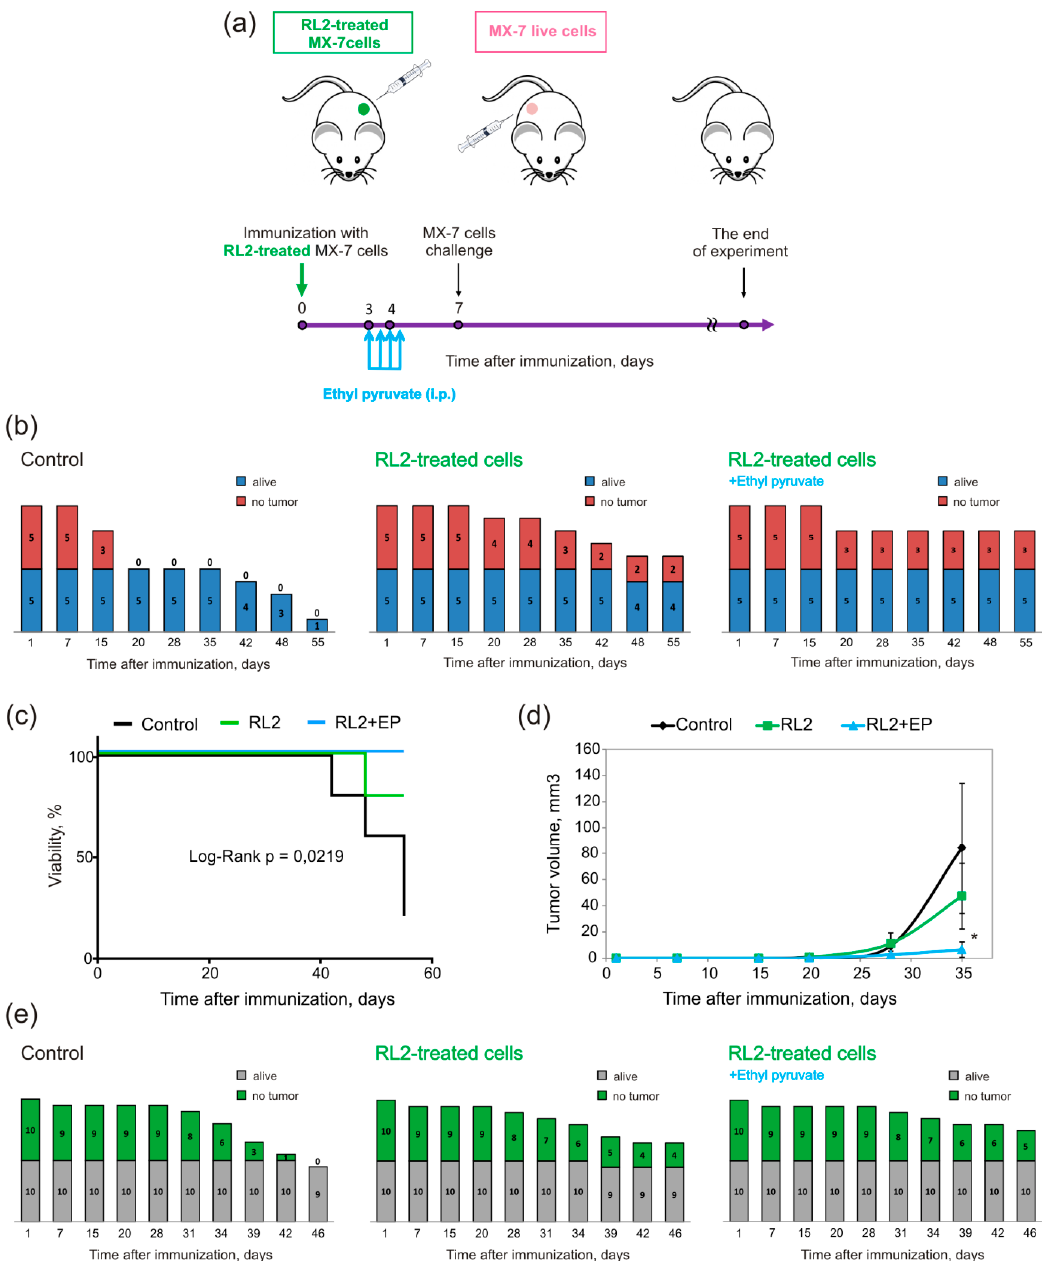
Figure 5. Ethyl pyruvate (EP) increases the vaccination effect of RL2-treated cells. ( a ) Scheme of C3H/He mice immunization with MX-7 cells treated by RL2 and EP injections. ( b ) Dynamic of live and tumor-free mice in groups. Syngeneic mice were s.c. immunized with RL2-treated MX-7 cells (7 × 10 5 cell/animal) and three days after that mice were i.p. injected with EP (40 mg/kg) according the scheme. Seven days after, the mice were challenged s.c. on the opposite flank with 2.5 × 10 5 live MX-7 cells. ( c ) Viability of vaccinated mice. ( d ) Dynamics of tumor growth. ( e ) Dynamic of live and tumor-free mice in groups. Syngeneic mice were s.c. immunized with RL2-treated MX-7 cells (5 × 10 5 cell/animal), EP injected and MX-7 challenged according to the scheme. The differences between groups were calculated using non-parametric statistics, Pearson ′ s chi-square test, and these were significant with p < 0.05. Kaplan–Myer survival curves and Log-Rank statistics were calculated using GraphPad Prizm Software (San-Diego, CA, USA).